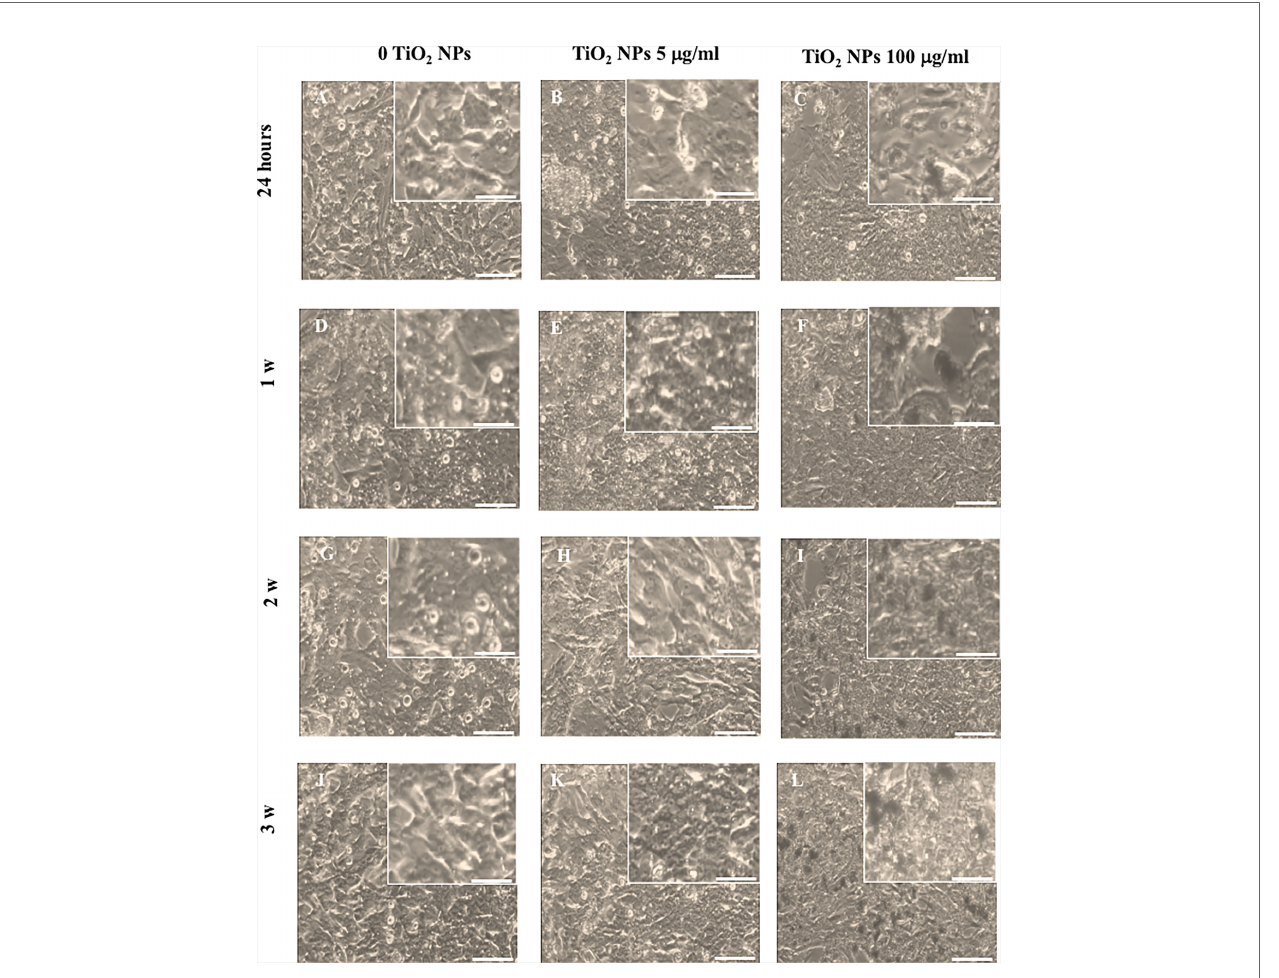
FIGURE 2 | Morphological characterization. Light microscope of unexposed (0 TiO 2 NPs) SCs (A, D, G, J) , TiO 2 NPs 5 (B, E, H, K) , and 100 µg/ml (C, F, I, L) exposed SCs at 24 h (A – C) and 1 (D – F) , 2 (G – I) , and 3 weeks (L – N) . The inserts show in detail the morphological characteristics of the respective images. The scale bar corresponds to 200 µm for (A – N) and 60 µm for the corresponding insets. The images are representative of three separate